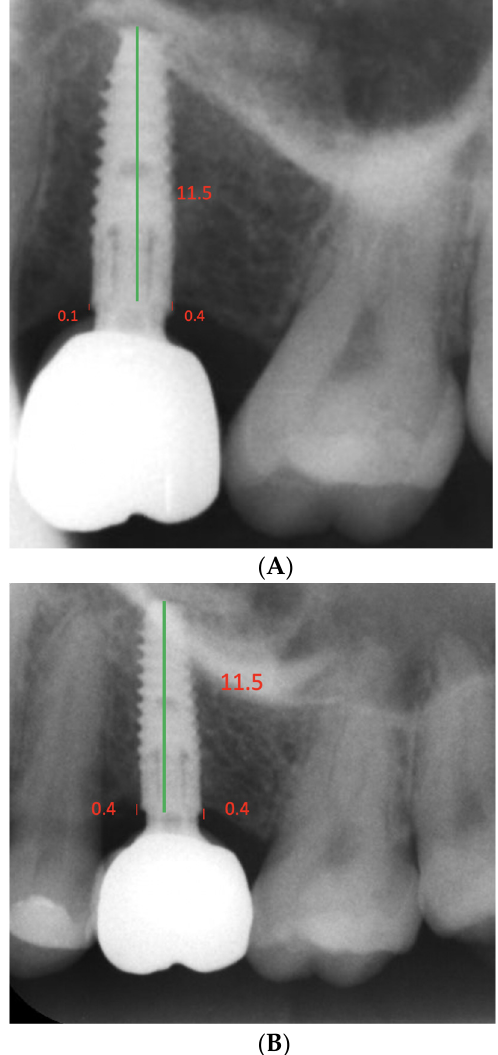
Figure 4. ( A ): Measurements of the hard tissue parameters using standardized long cone radiographs implant length (green vertical line). ( B ): Distance between the neck and the first bone-implant contact (red vertical line).